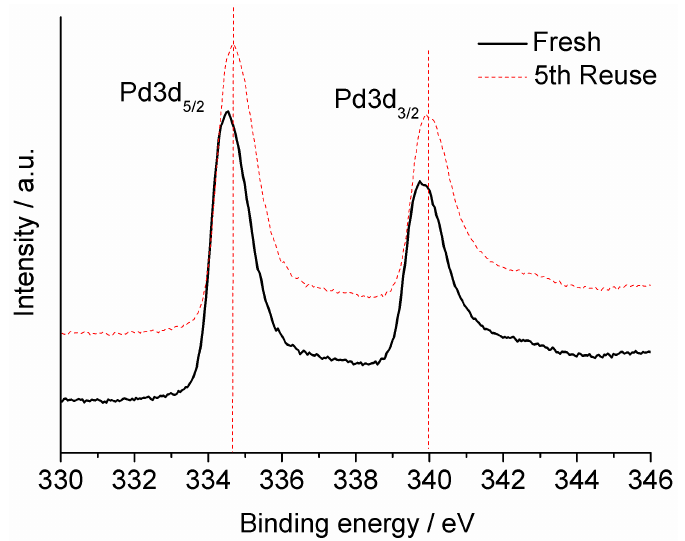
Figure 7. XPS spectra of 5th recycled Pd/PP ‐ 3 catalyst.